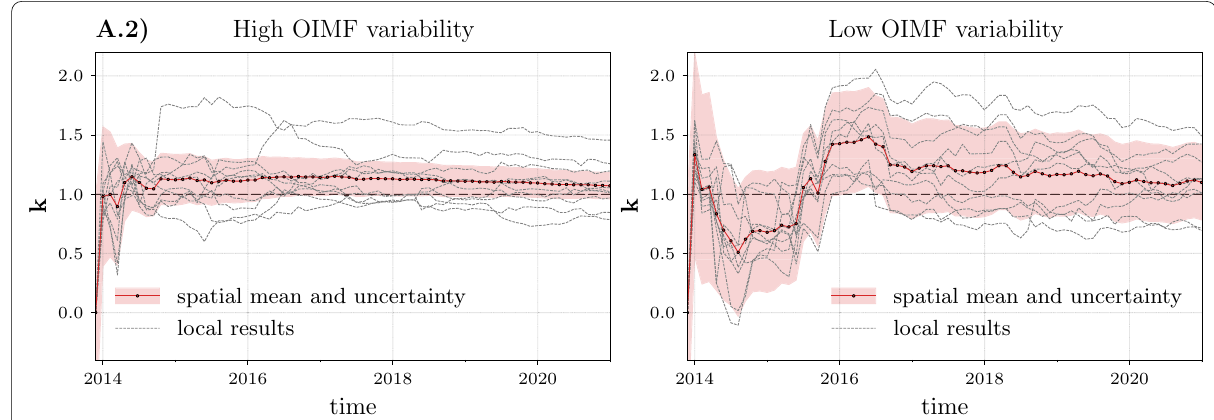
Fig. 7 The scale factor evolution for test case scenario A.2). As in Fig. 5, the evolution is presented over the entire period and for two different areas of high (left) and low (right) variability of the OIMF. Again, both local results (grey) and spatial mean (red) are shown. However, in the assimilation shown here, an exponentially decaying spatial covariance structure is used at the beginning of the